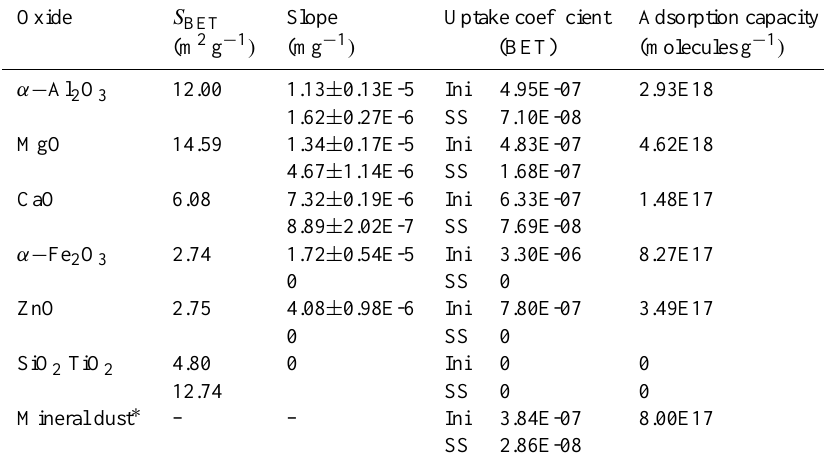
Table 1. Uptake coefficients and adsorption capacities of OCS on mineral oxides.